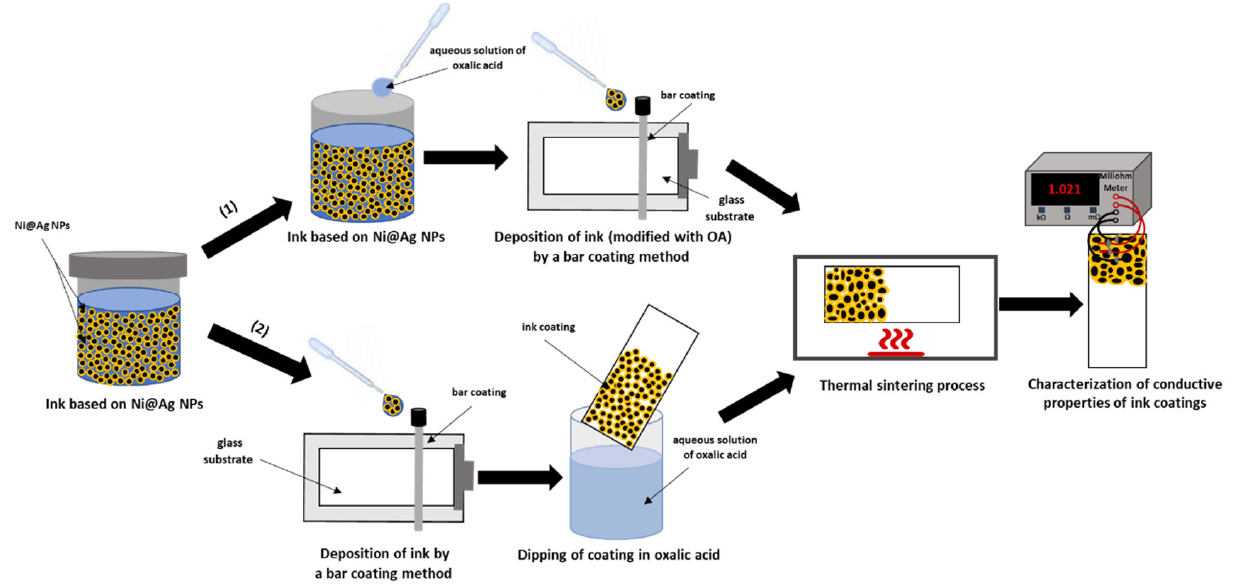
Figure 1. Scheme of the preparation of the conductive coatings based on Ni@Ag NPs: (1) with addition of oxalic acid to ink formulation; (2) after post-printing treatment with OA.